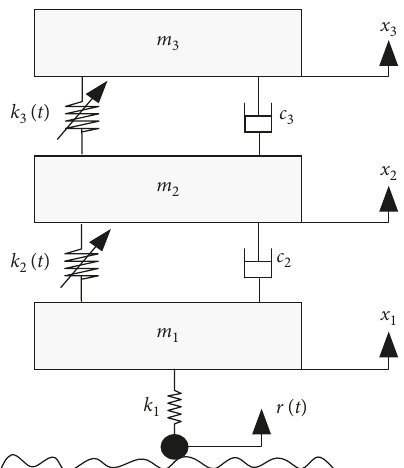
Figure 1: Schematic diagram of a TV structural system.